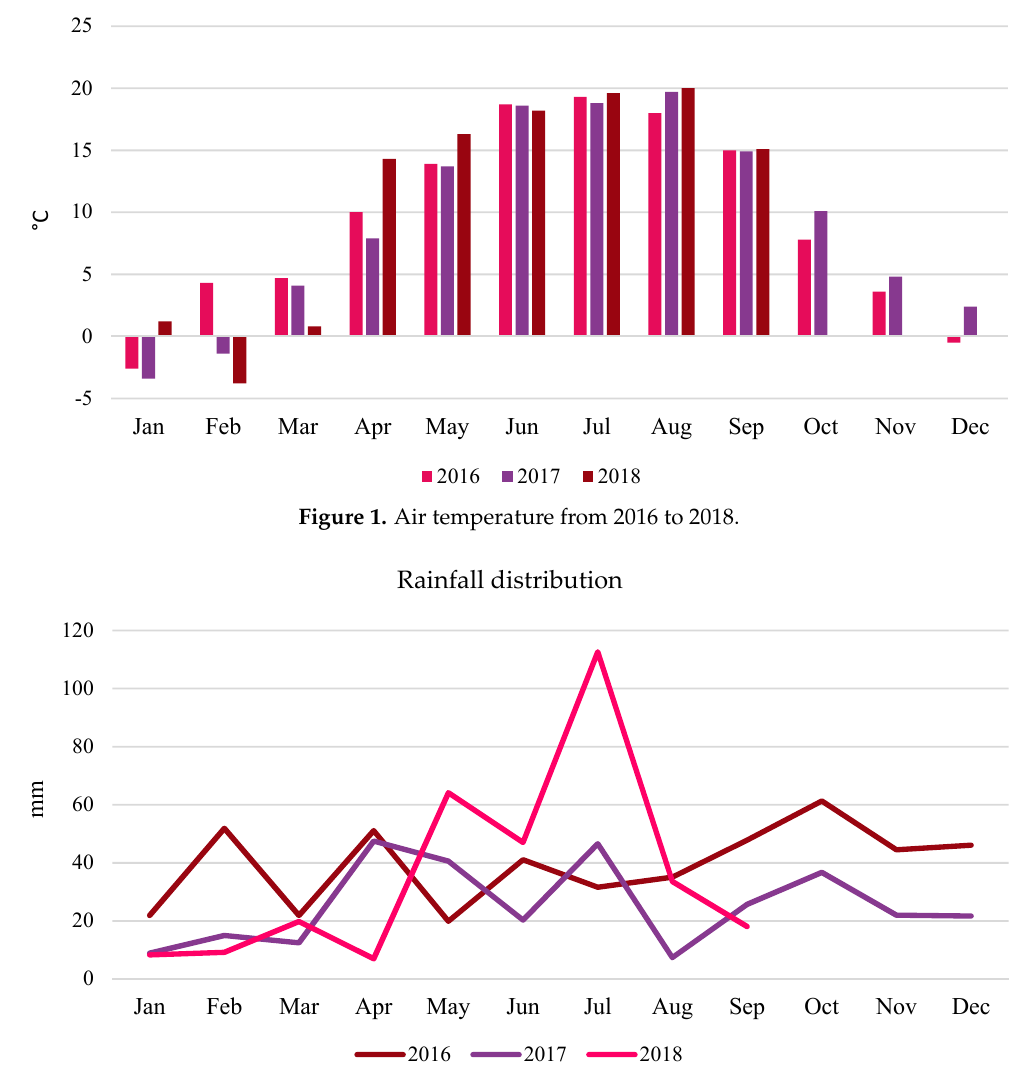
Figure 2. Rainfall distribution from 2016 to 2018.